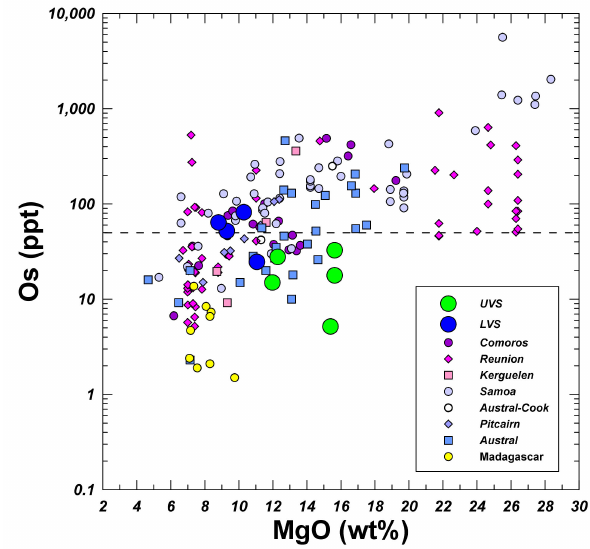
Figure 12. Os (ppt) versus MgO (wt%) for the Christmas Island lava series compared to other intraplate lava suites. Data sources as follows: Comoros [81]; Reunion [82–84]; Kerguelen [85]; Samoa [86,87]; Pitcairn [66]; Austral [82,88]; Austral-Cook [89]; Madagascar [74]. The horizontal dotted line at Os 50 ppt is the proposed cut off filter [79] to eliminate crustally contaminated lavas. The LVS lava have overall lower 187 Os/ 188 Os i(initial) isotopic values (0.123–0.150; γ Os γ Os i = –3.4 to 17.5; Table 3) than the UVS lava (0.144–0.167; i = 12.6 to 31.7; Table 3). In Figure 13 187 Os/ 188 Os isotopic values are plotted against Os abundances (ppt) at two different scales. In Figure 13a, the Christmas Island lava series plot in the bottom left corner—where we expect to see uncontaminated mantle derived lava ( 187 Os/ 188 Os values of ≤ 0.15; [90]). In Figure 13b the data falling inside the shaded rectangle in Figure